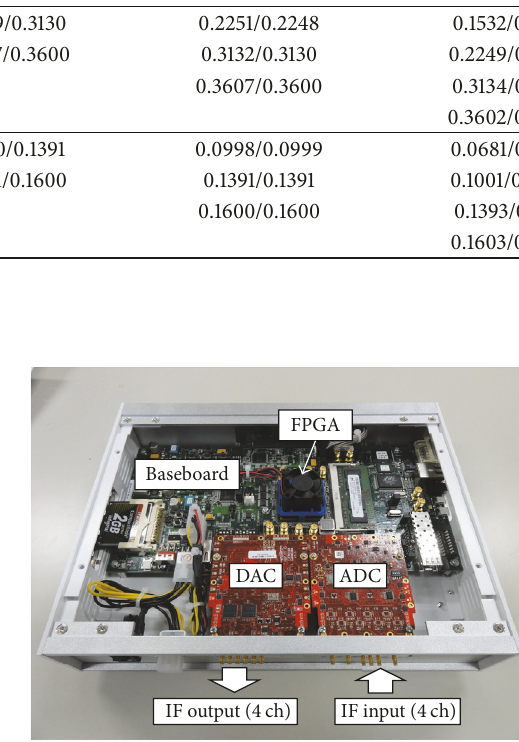
Figure 10: MIMO-FE as implemented on an FPGA (case size is 28 × 22 × 5